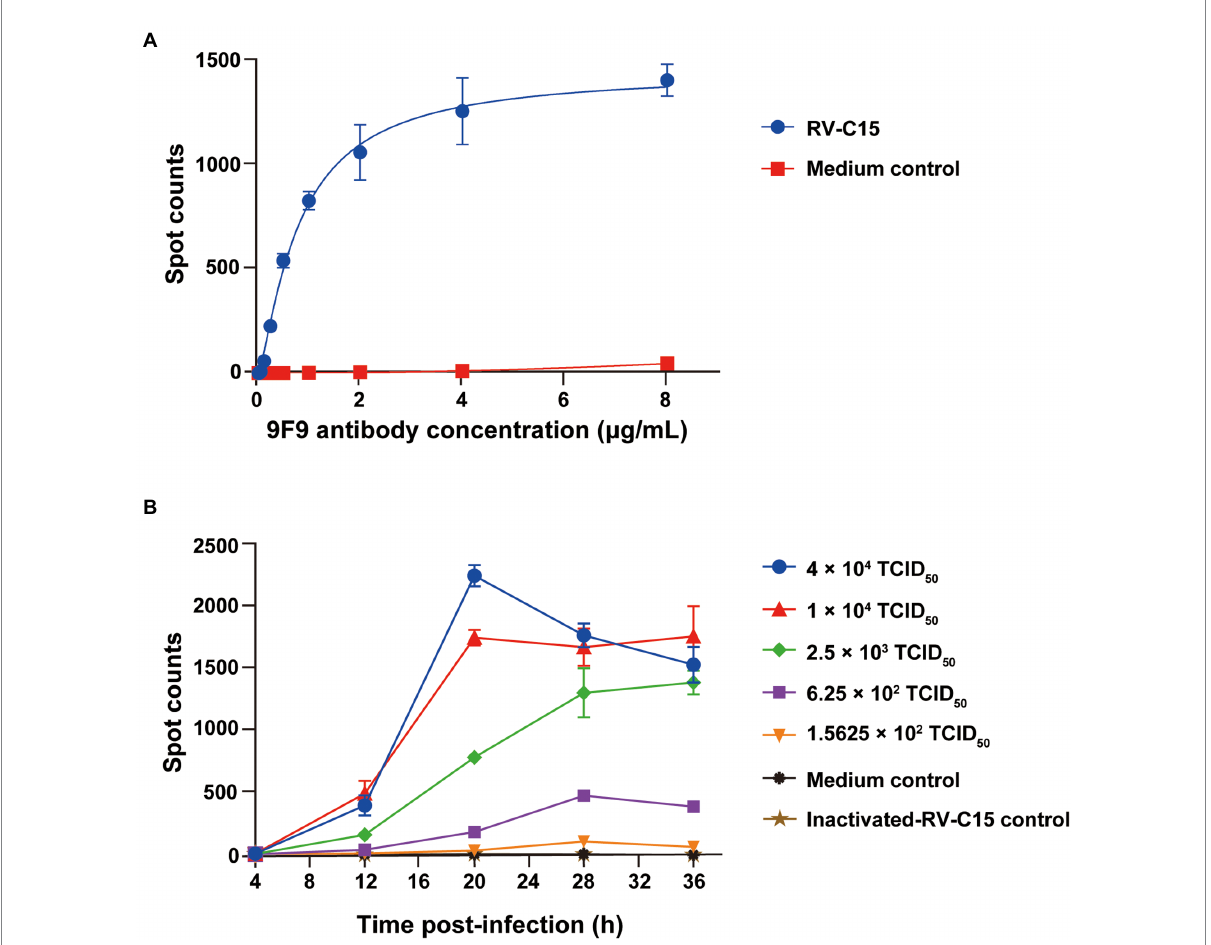
FIGURE 4 Influence of infection parameters for the Nt-ELISPOT. (A) Determination of the optimal antibody concentration for the Nt-ELISPOT. The H1- Hela-R3 cells were infected with RV-C15 at 1 × 10 4 TCID 50 per well. The detection was then performed with serially diluted antibodies HRP-9F9. (B) Determination of the optimal infectious dose and incubation time for the Nt-ELISPOT. The H1-Hela-R3 cells were infected with RV-C15 in a 4-fold serial dilution from 4 × 10 4 to 1.5625 × 10 2 TCID 50 per well, and the number of spots was counted every 8 h over a period of 36 h using the ELISPOT assay. Inactivated-RV-C15 was inactivated at 56 ° C for 30 min and then added to the culture wells, which served as a negative control as well as medium group. Each of the dilutions was performed in triplicate. The error bars indicate the mean ± SD from three independent